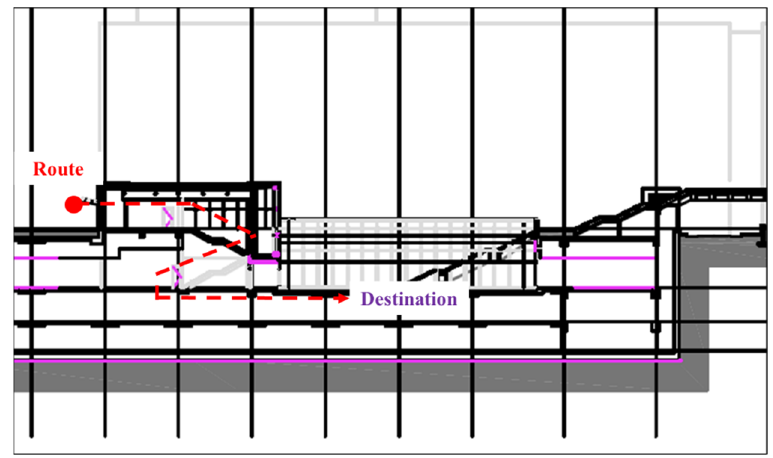
Figure 15. Scanning path of Case 2 (Campus building B).